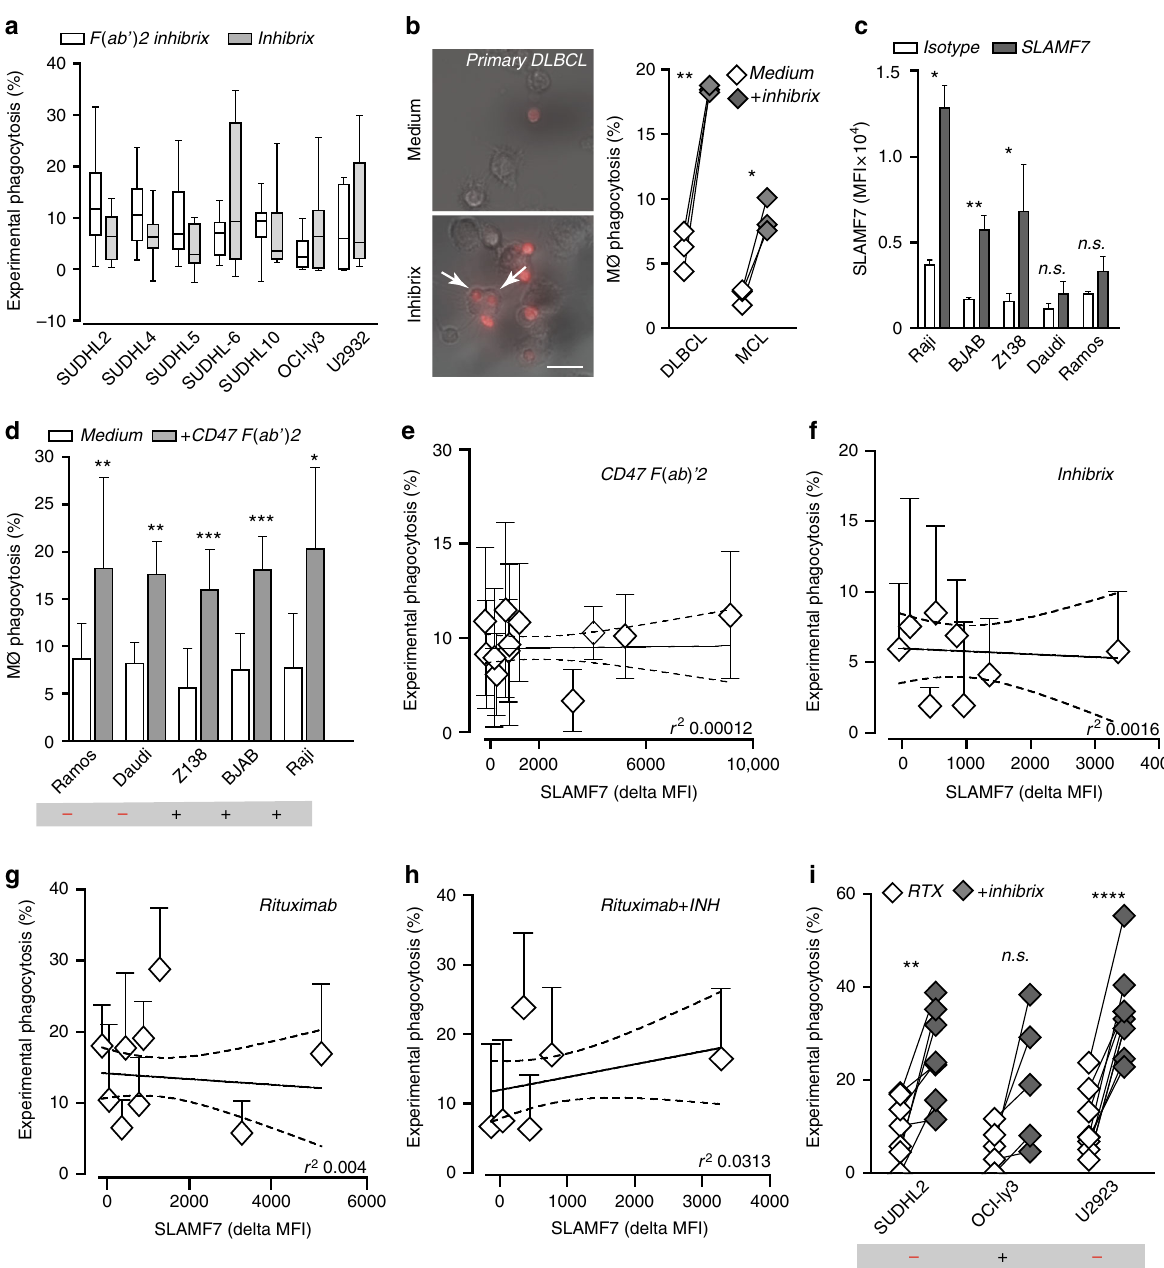
Fig. 3 Ef fi cacy of CD47-targeting antibodies in B-cell malignant cells does not correlate with SLAMF7 expression. a Experimental phagocytosis of DLBCL lines by macrophages either upon CD47 F(ab ′ )2 treatment or inhibrix treatment ( n = 3). Box plot contains center line representing median and whiskers representing 5 – 95%. b Representative microscopy pictures of phagocytosis of primary DLBCL cells by autologous macrophages upon 3 h treatment with inhibrix. Quanti fi cation of phagocytosis of primary DLBCL and MCL cells by autologous macrophages. c Quanti fi cation of surface SLAMF7 expression on fi ve NHL lines ( n = 3). d Percentage of phagocytosis of NHL cell lines by allogeneic human macrophages primed with LPS/IFN- γ upon 3 h treatment with F (ab ′ )2 of anti-CD47 antibody inhibrix (CD47 F(ab ′ )2) vs. untreated cells ( n = 3 – 4). e Correlation between SLAMF7 expression and the percentage of experimental phagocytosis induced by CD47 F(ab ′ )2 in NHL and DLBCL cell panel ( n = 3). f Correlation between SLAMF7 expression and the percentage of experimental phagocytosis induced by anti-CD47 antibody inhibrix in DLBCL cell panel ( n = 3 – 4). g Correlation between SLAMF7 expression and the percentage of experimental phagocytosis induced by Rituximab in NHL and DLBCL cell panel ( n = 3). h Correlation between SLAMF7 expression and the percentage of experimental phagocytosis induced by the combinatory treatment of Rituximab and Inhibrix in DLBCL cell panel ( n = 3). i Experimental phagocytosis of tumor cells by macrophages upon RTX treatment or combination treatment with inhibrix ( n = 3). Experiments with primary patient-derived samples were performed in triplicates. Statistics was performed using paired Student ’ s t -test. n.s. = not signi fi cant, * p < 0.05; ** p < 0.01; *** p < 0.001; **** p < 0.0001. Error bars stand for standard deviation